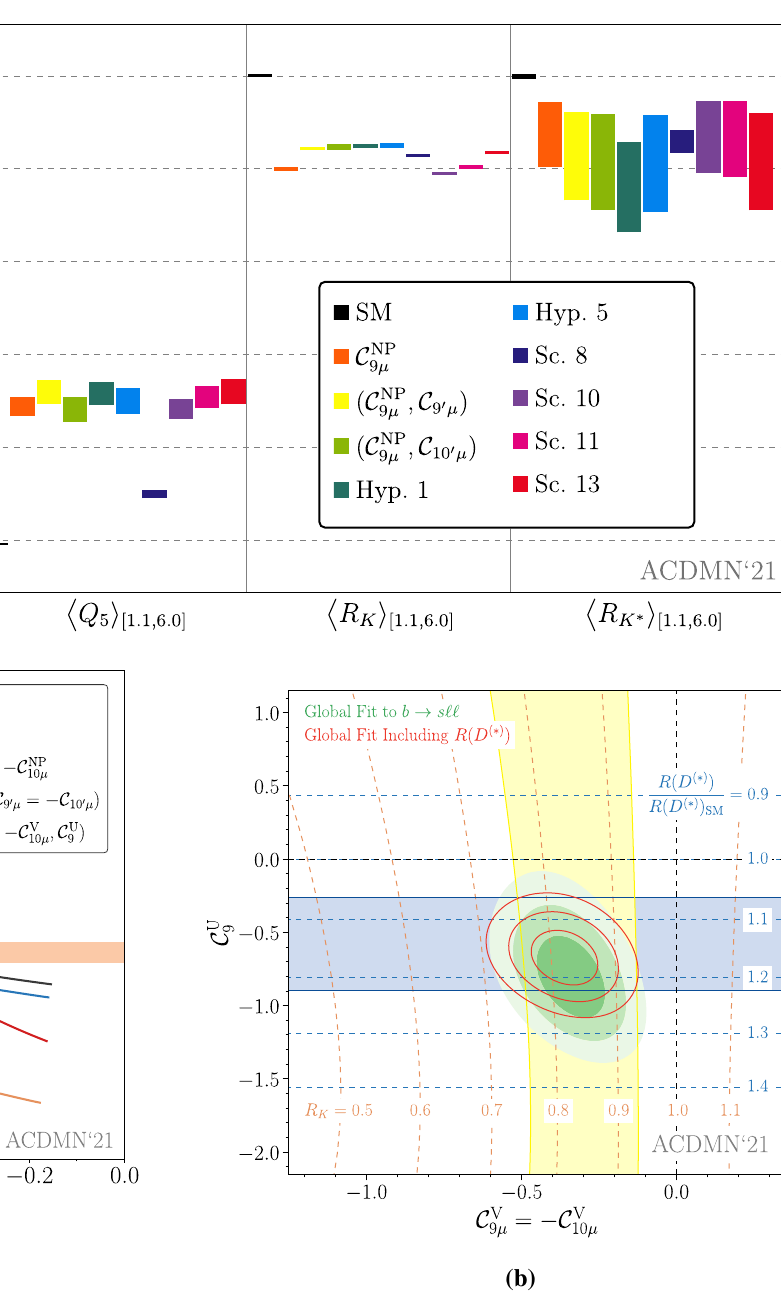
(cid:9) [ Fig. 4 Left: (cid:8) R K (cid:9) [ 1 . 1 , 6 ] versus (cid:8) P (cid:4) dotscorrespond totheb.f.p. values ofthecorresponding scenarioforthe 4 , 6 ] in five different scenarios: 5 = − C NP = − C V , C U ) (red), C NP fit to the “All” data set. Right: Preferred regions at the 1, 2 and 3 σ level (blue), C NP (orange), and ( C V 9 μ 9 μ 10 μ 9 μ 10 μ 9 = − C V , C U ) plane from b → s (cid:2)(cid:2) data. The red , C = − C ) (black), and C NP ( C NP (green) in the ( C V (purple). The curves corre- 9 (cid:4) μ 10 (cid:4) μ 9 μ 10 μ 9 9 μ 10 μ contour lines show the corresponding regions once R D ( ∗ ) is included in spond only to the predictions for central values. In the 2D scenarios the fit (for (cid:5) = 2 TeV). The horizontal blue (vertical yellow) band is (red and black) the Wilson coefficient not shown is set to its b.f.p. value. consistent with R D ( ∗ ) ( R K ) at the 2 σ level and the contour lines show The current experimental values from the LHCb collaboration are also the predicted values for these indicated (orange horizontal and green vertical bands respectively). The